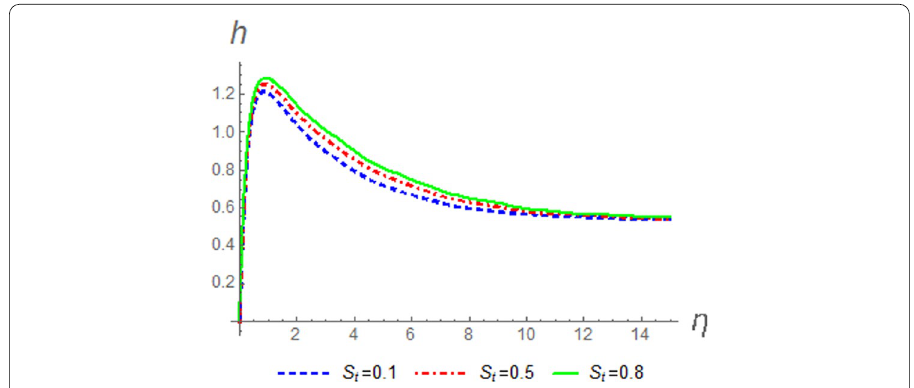
Fig. 17 Effect of S t on the velocity profile